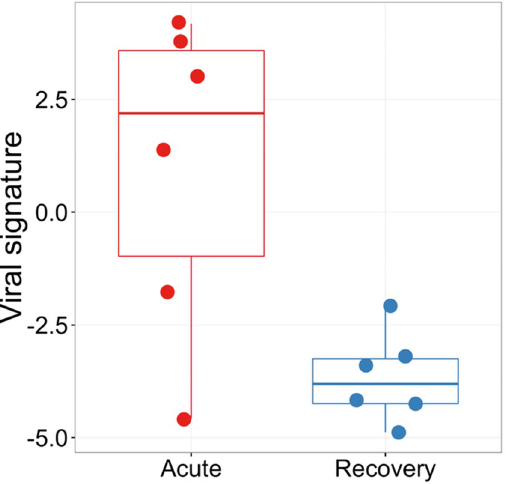
Figure 2. Pan-viral signature scores for children with rotavirus infection. Box and whisker plots showing pan-viral signature scores in peripheral blood for six children in the acute versus recovery stages of rotavirus infection (E-GEOD-50628). The pan-viral signature produced AUC =